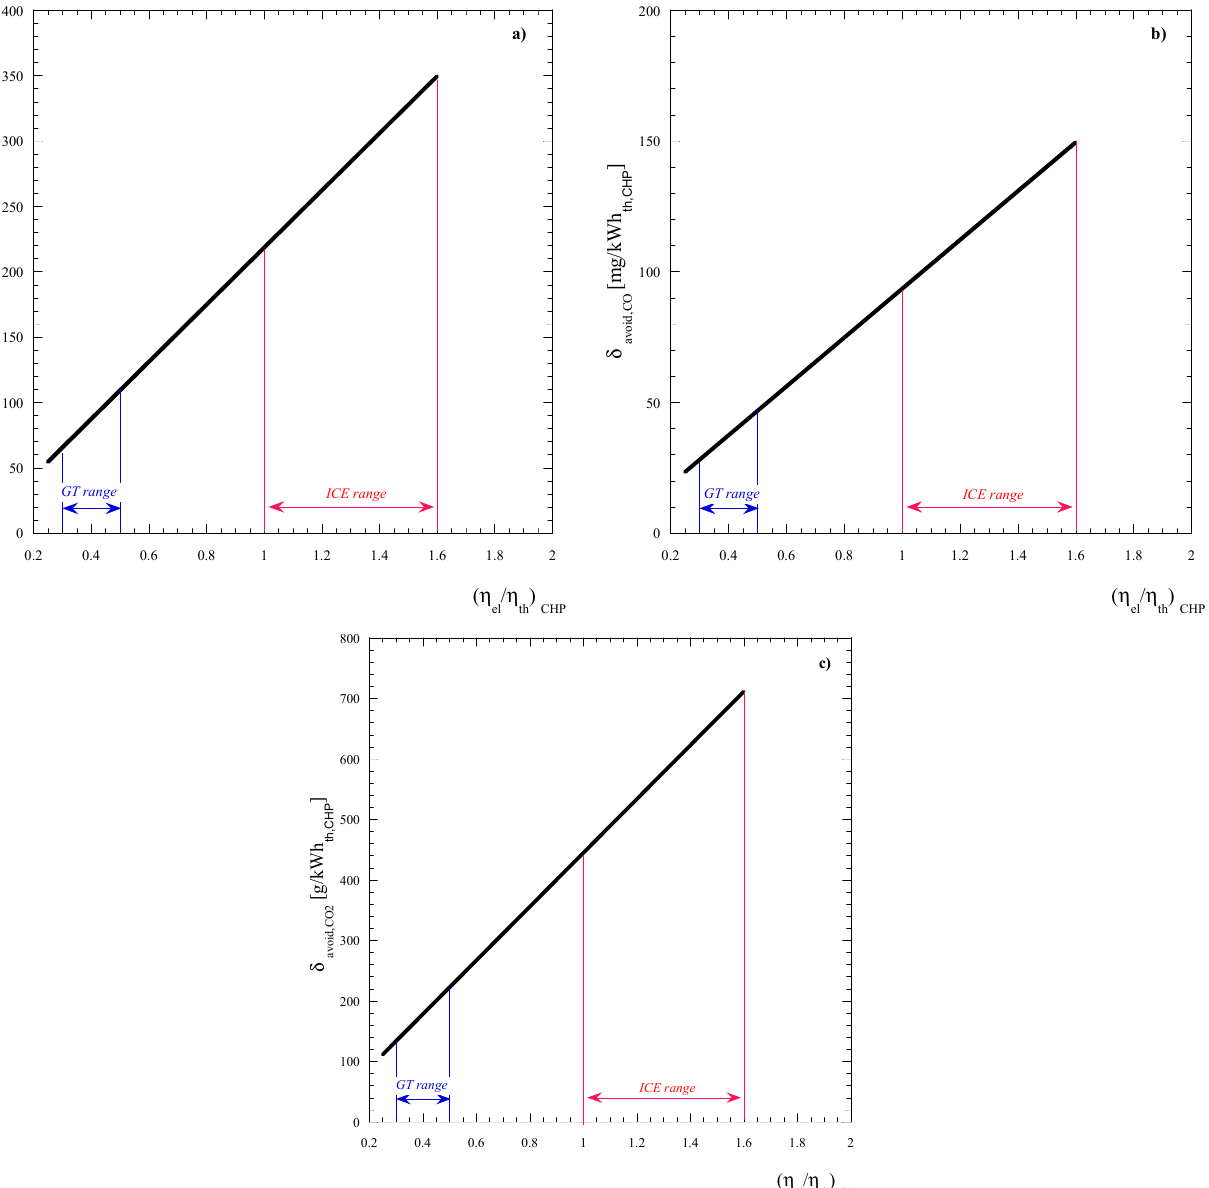
Figure 8. Avoided specific emission factor as function of CHP efficiencies ratio; ( a ) NO X , ( b ) CO, ( c ) CO 2